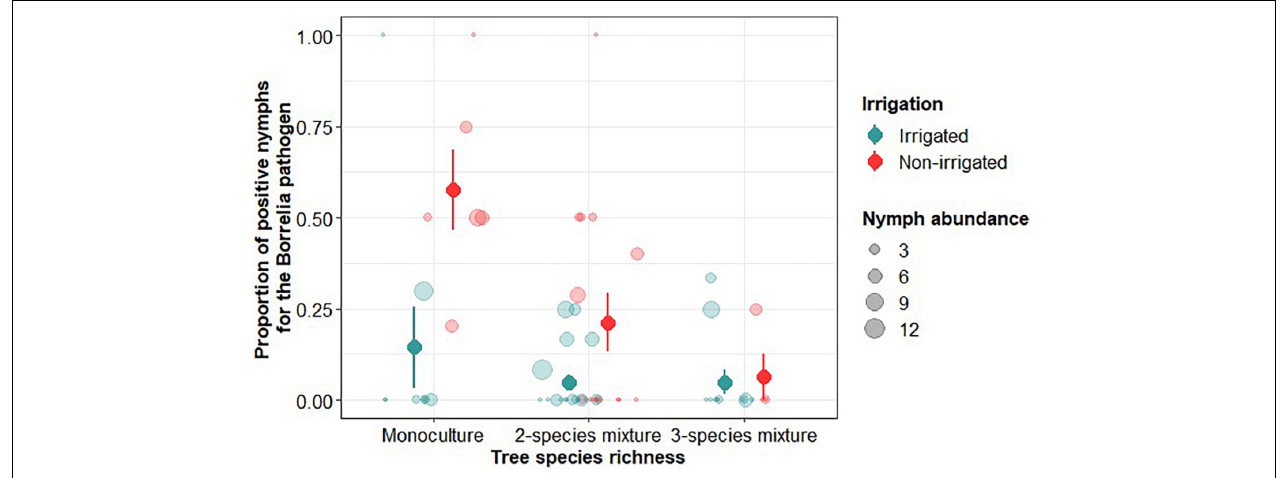
FIGURE 6 | Proportion of positive Ixodes ricinus nymphs for Borrelia burgdorferi s.l. pathogen as a function of tree species richness and irrigation. The size of the dots is proportional to the total number of nymphs on which the proportion of positive nymphs was calculated. Dots and solid lines represents mean ± SE calculated on raw